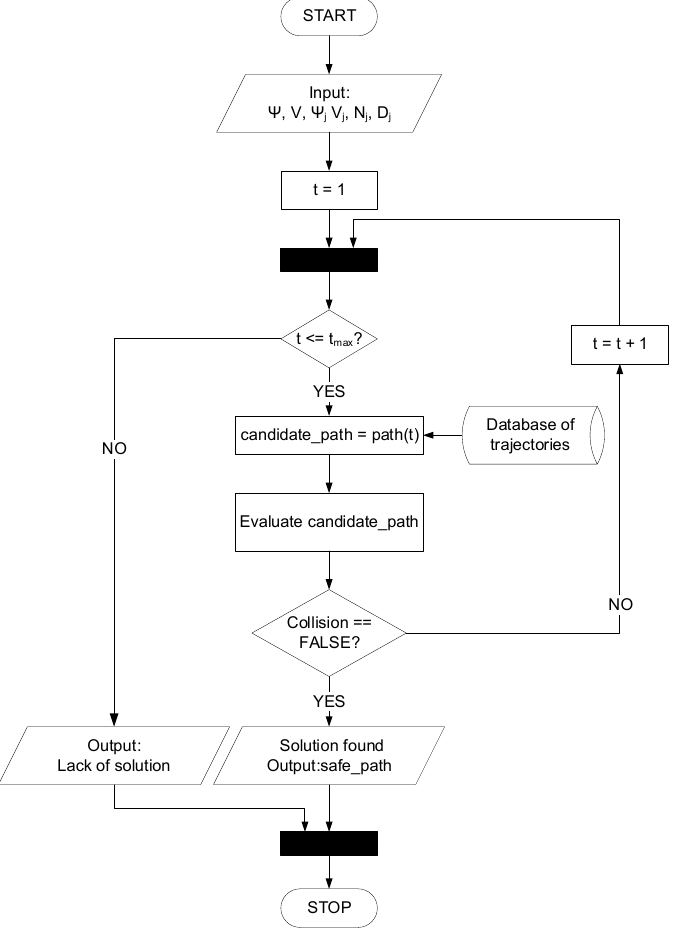
Figure 5. A flowchart of the Trajectory Base